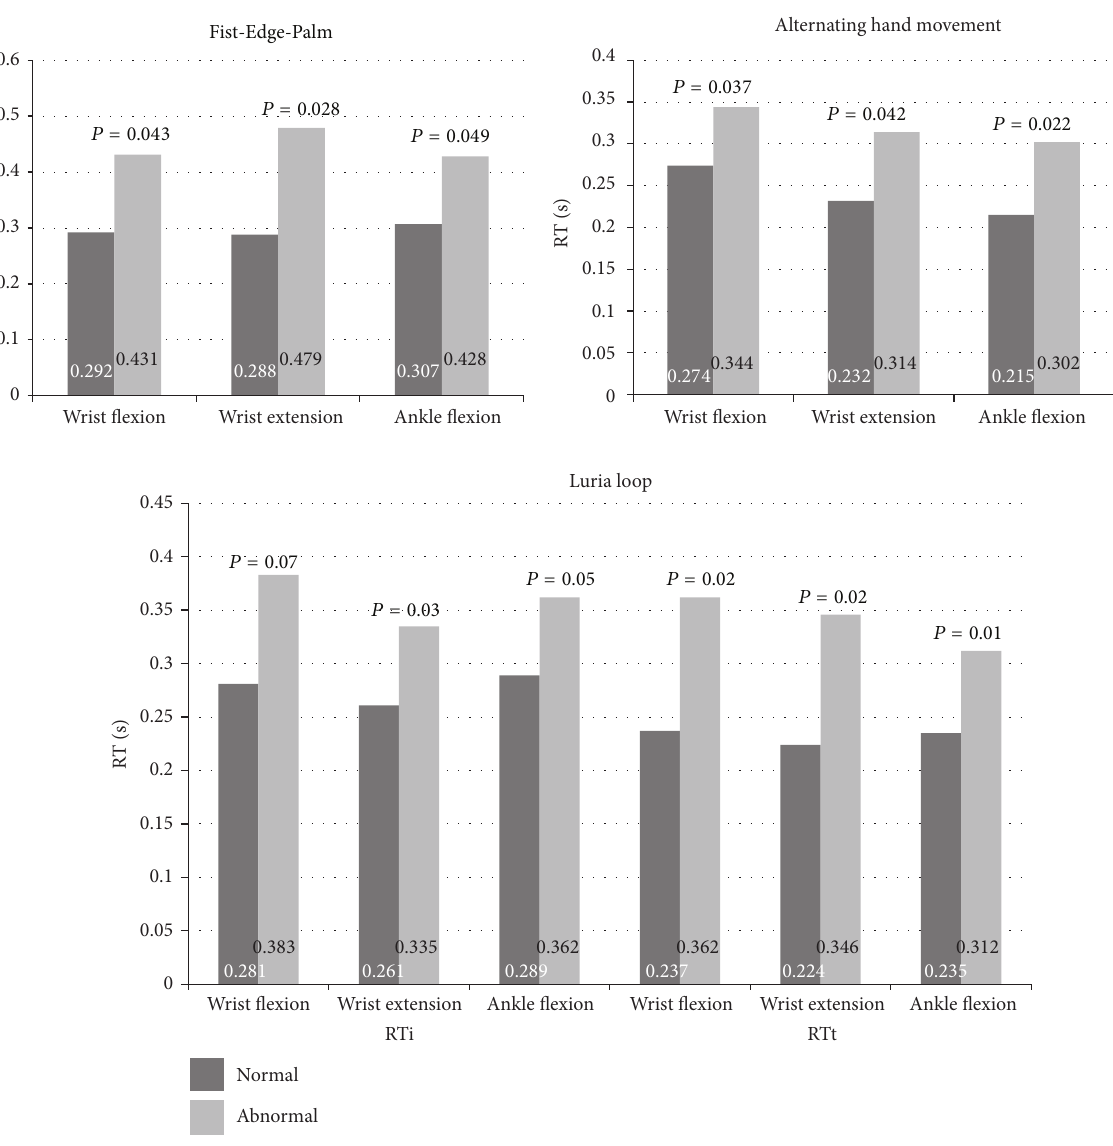
Figure 3: Comparison of the electromyographic reaction time (sec) according to the results of the frontal lobe functions